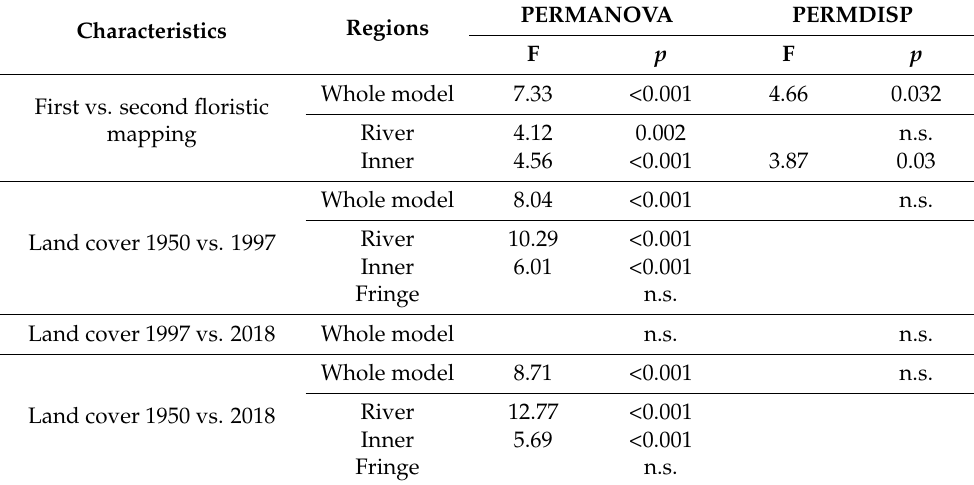
Table 1. The permutational multivariate analysis of variance using distance matrices (PERMANOVA) and multivariate homogeneity of groups dispersions (PERMDISP) for the land-cover and floristic data were based on the Bray–Curtis dissimilarity for land cover and Sörensen dissimilarity for floristic presence/absence data. n.s.—not significant. PERMANOVA PERMDISP Characteristics Regions F p F p Whole model 7.33 <0.001 First vs. second floristic River mapping